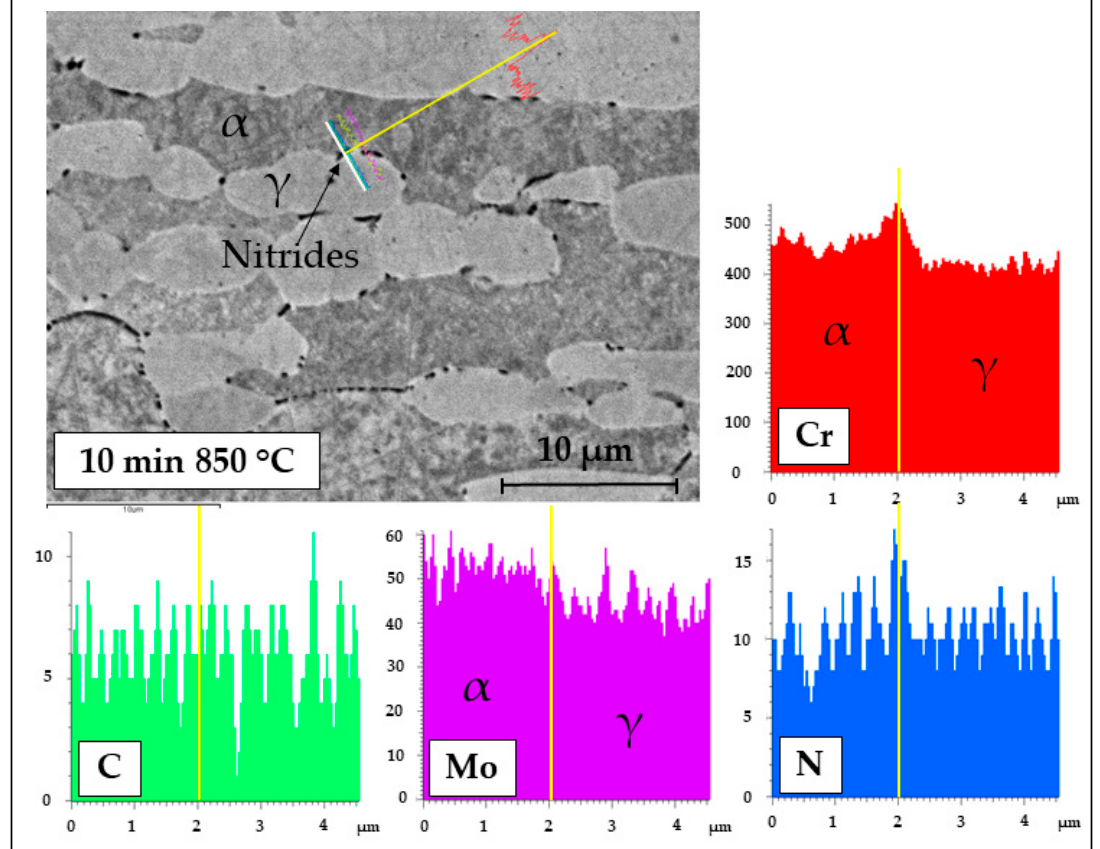
Figure 3. SEM-BSE microstructure of the transverse section of LDSS 2404 and EDS profile-line analysis (white segment through the particles at the α / γ interface) of chromium, nitrogen, molybdenum, and carbon.